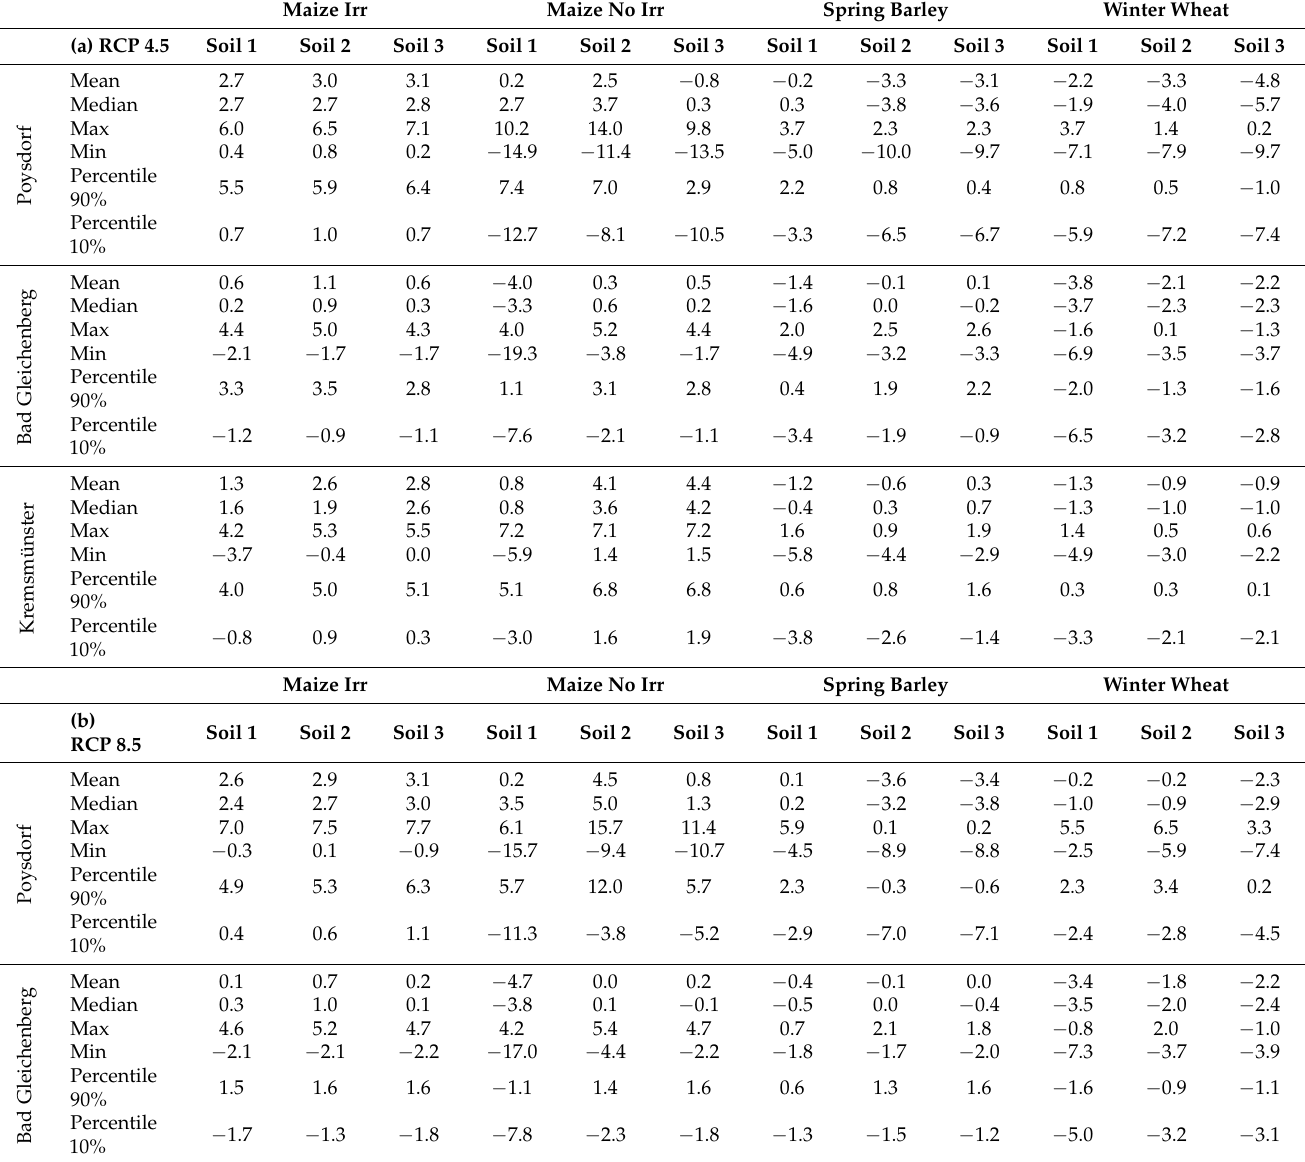
Table A2. Mean, Median, Maximum (Max), and Minimum (Min) values, as well as 90th and 10th percentiles for all ÖKS15 yield differences (in %) (projections vs. ZAMG simulations) for three different soil classes: (a) RCP 4.5; and (b) RCP 8.5; baseline in Poysdorf, Bad Gleichenberg, and Kremsmünster (irr = irrigated; no irr =